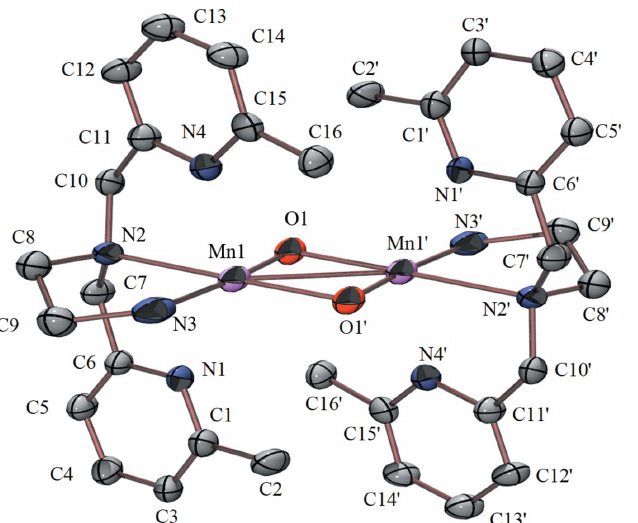
Figure 1 Ellipsoid plot of {[Mn IV (N 4 (6-Me-DPEN))] 2 ( (cid:2) -O) 2 } 2+ ( 1 ) showing the atom-labeling scheme. The anions and all hydrogen atoms have been removed for clarity. Displacement ellipsoids are drawn at the 50% probability level. Symmetry code for primed atoms -x , (cid:3) y + 1, (cid:3) z +